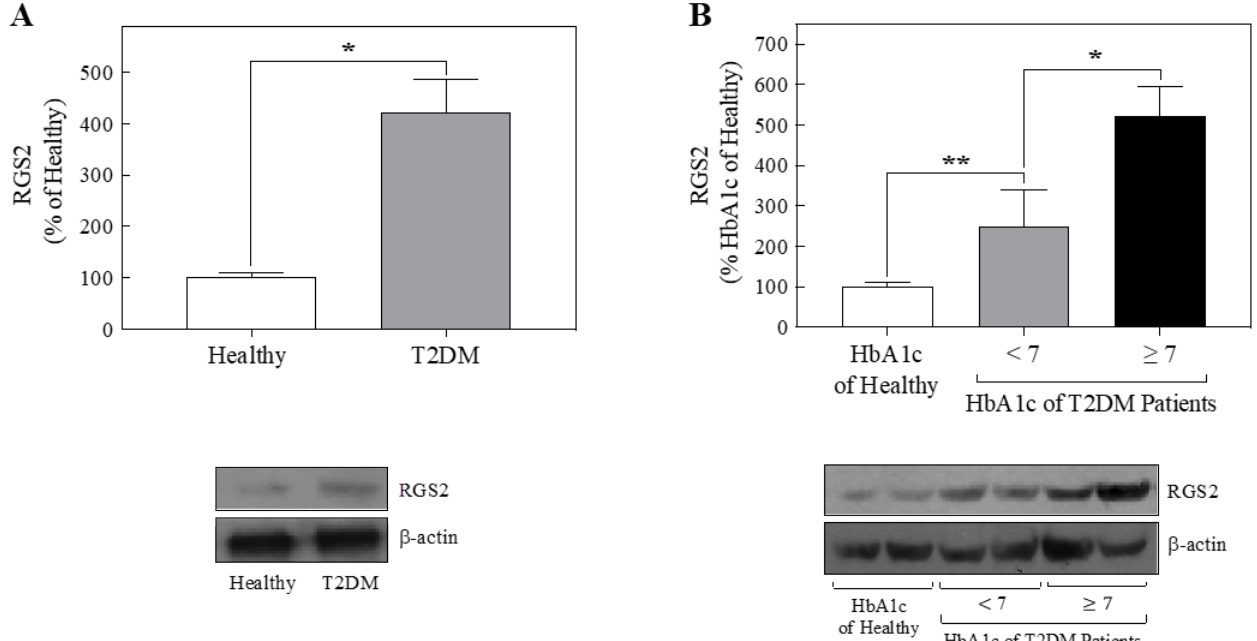
Figure 2. T2DM patients have increased levels of RGS2 protein. ( A ) Cell lysates from platelet-enriched fractions from blood samples of healthy individuals ( n = 6) and T2DM patients ( n = 11) were separated by sodium dodecyl sulfate-polyacrylamide gel electrophoresis (SDS-PAGE) and analyzed by immunoblotting with anti-RGS2. ( B ) Cell lysates from platelets-enriched fractions from blood samples of healthy individuals (glycated HbA1c < 5.7% n = 6) and T2DM patients with increasing percentages of glycated HbA1c (<7% n = 4 and ≥ 7% n = 7) were separated by SDS-PAGE and analyzed by immunoblotting with anti-RGS2. The graph indicates the mean ± S.E.M. Lower panels for ( A ) and ( B ) are representative immunoblots. Western blots were also probed for β -actin as a loading control. ( A ) * p < 0.05 vs. Healthy individuals, ( B ) * p < 0.05 vs. T2DM patients with glycated HbA1c < 7%; ** p < 0.01 vs. HbA1c of Healthy (control